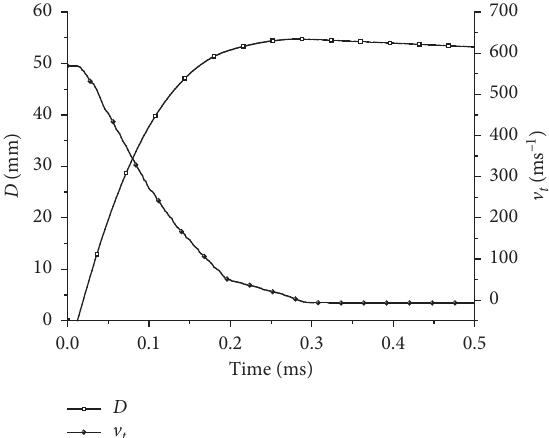
� 35.7, (b) r � 20, (c) r � 15, and (d) r t / a , (a) r t / a t / a t / a